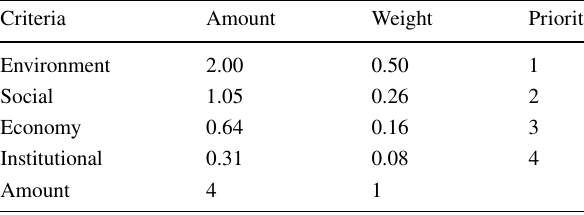
Table 4 Criteria weighting